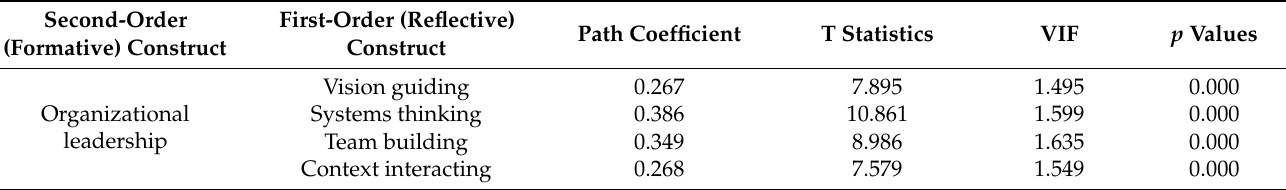
Table 6. Assessments of formative dimensions of organizational leadership.